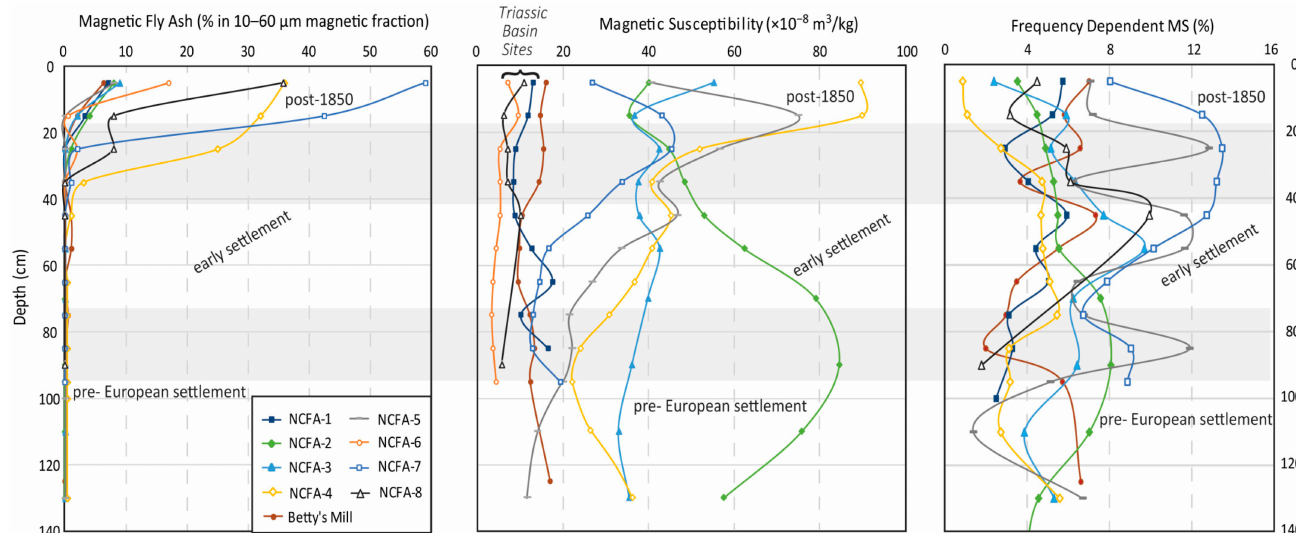
Figure 4. Magnetic fly ash (percent of 10–60 µ m magnetic fraction), low frequency magnetic susceptibility ( × 10 − 8 m 3 /kg) and frequency dependent magnetic susceptibility (%) with depth from alluvial samples and Betty’s Milldam sediments in central North